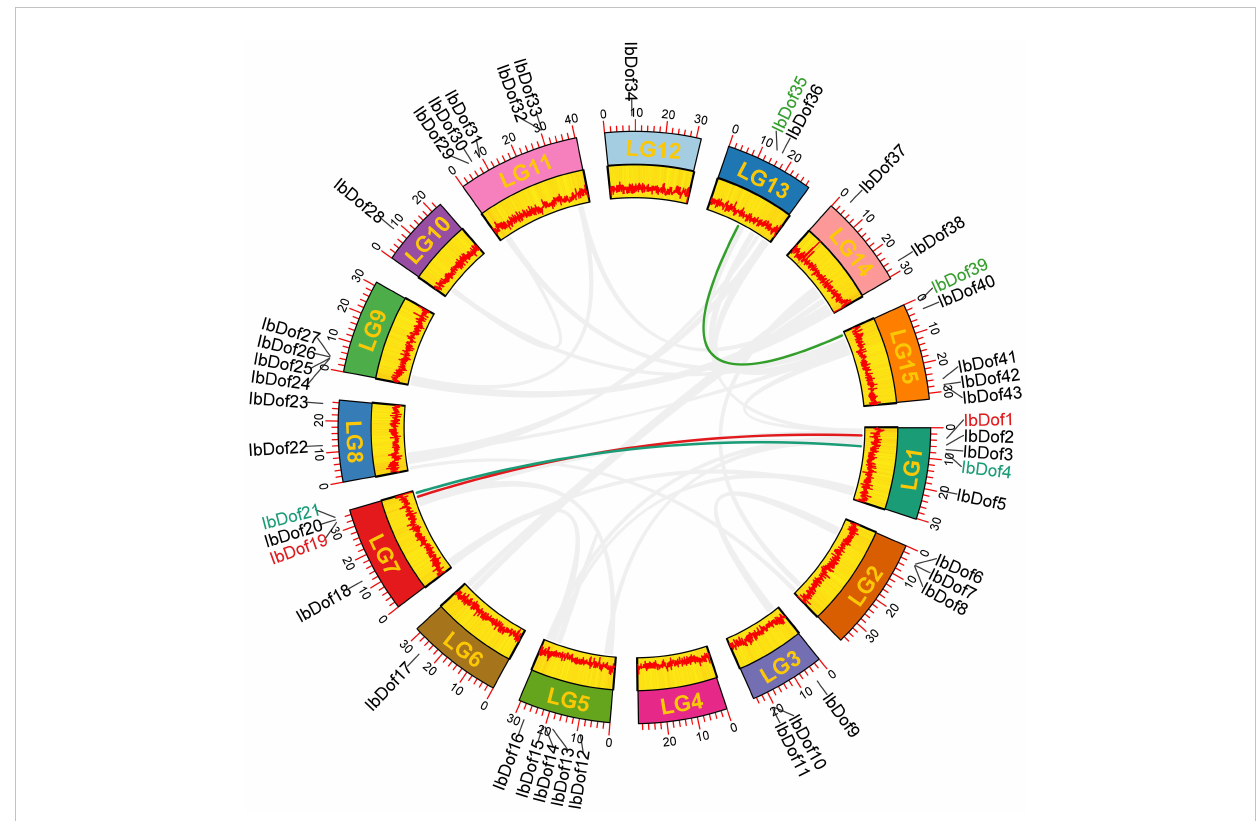
FIGURE 1 Chromosome distribution and synteny analysis of IbDof genes in sweetpotato chromosomes. Chromosomes LG1-LG15 are marked with colored rectangles, the location of each IbDof is represented by a short black line, the colored lines represent segmentally duplicated IbDof